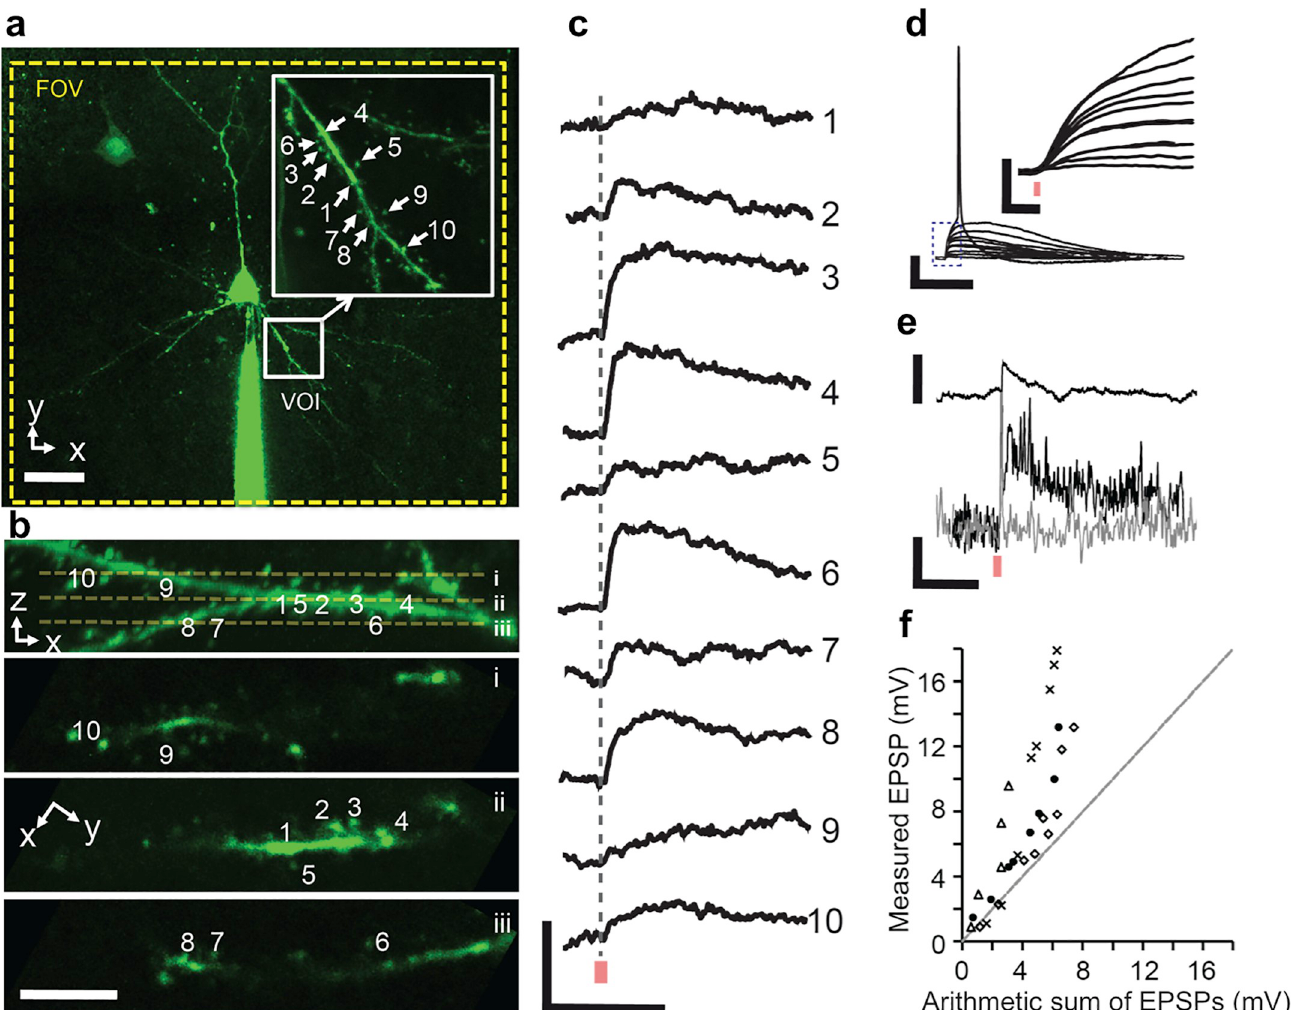
Fig 4. Representative synaptic integration experiment. a : Two-photon image of a layer 2/3 pyramidal neuron labeled with OGB-1 taken with a 60 × objective. Inset shows a high-magnification flattened multi-stack image of the VOI. Scale bar: 20 μ m. b : VOI displayed as an xz -image with 3 representative image planes (i: z = − 5 μ m; ii: z = 0; and iii: z = + 5 μ m. Scale bar: 5 μ m. c : Somatic EPSPs of individual uncaging events (red bar indicates time point of 2P glutamate uncaging). Scale bars: 1 mV, 40 ms. d : Uncaging responses with increasing number of simultaneous uncaging sites. Scale bars: 20 mV, 50 ms. (Inset) Magnified EPSP rise times for increasing number of uncaging sites. Scale bars: 5 mV, 5 ms. e : Representative individual uncaging-evoked EPSP (top) and Ca 2+ transient ( Δ F/F) (bottom) measured at spine 4 (black) and nearby dendrite (gray). Scale bars: 2 mV, 20%, 500 ms. f : Input-output plot ( n = 4) of measured multisite uncaging response against the arithmetic sum of individual uncaging events. Dashed line indicates linear summation, black circles represent data from a while all other markers represent data from other experiments.